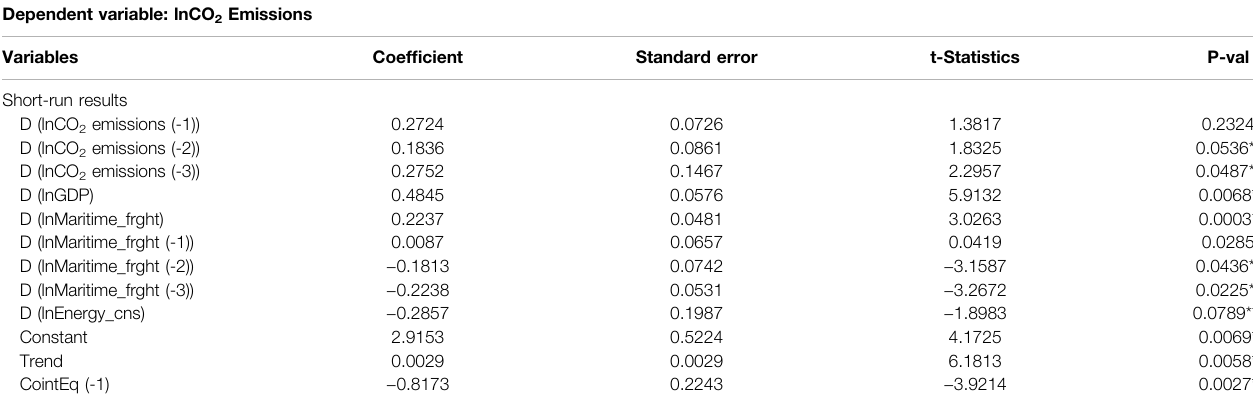
TABLE 11 | Short-term ARDL results and error correction model of